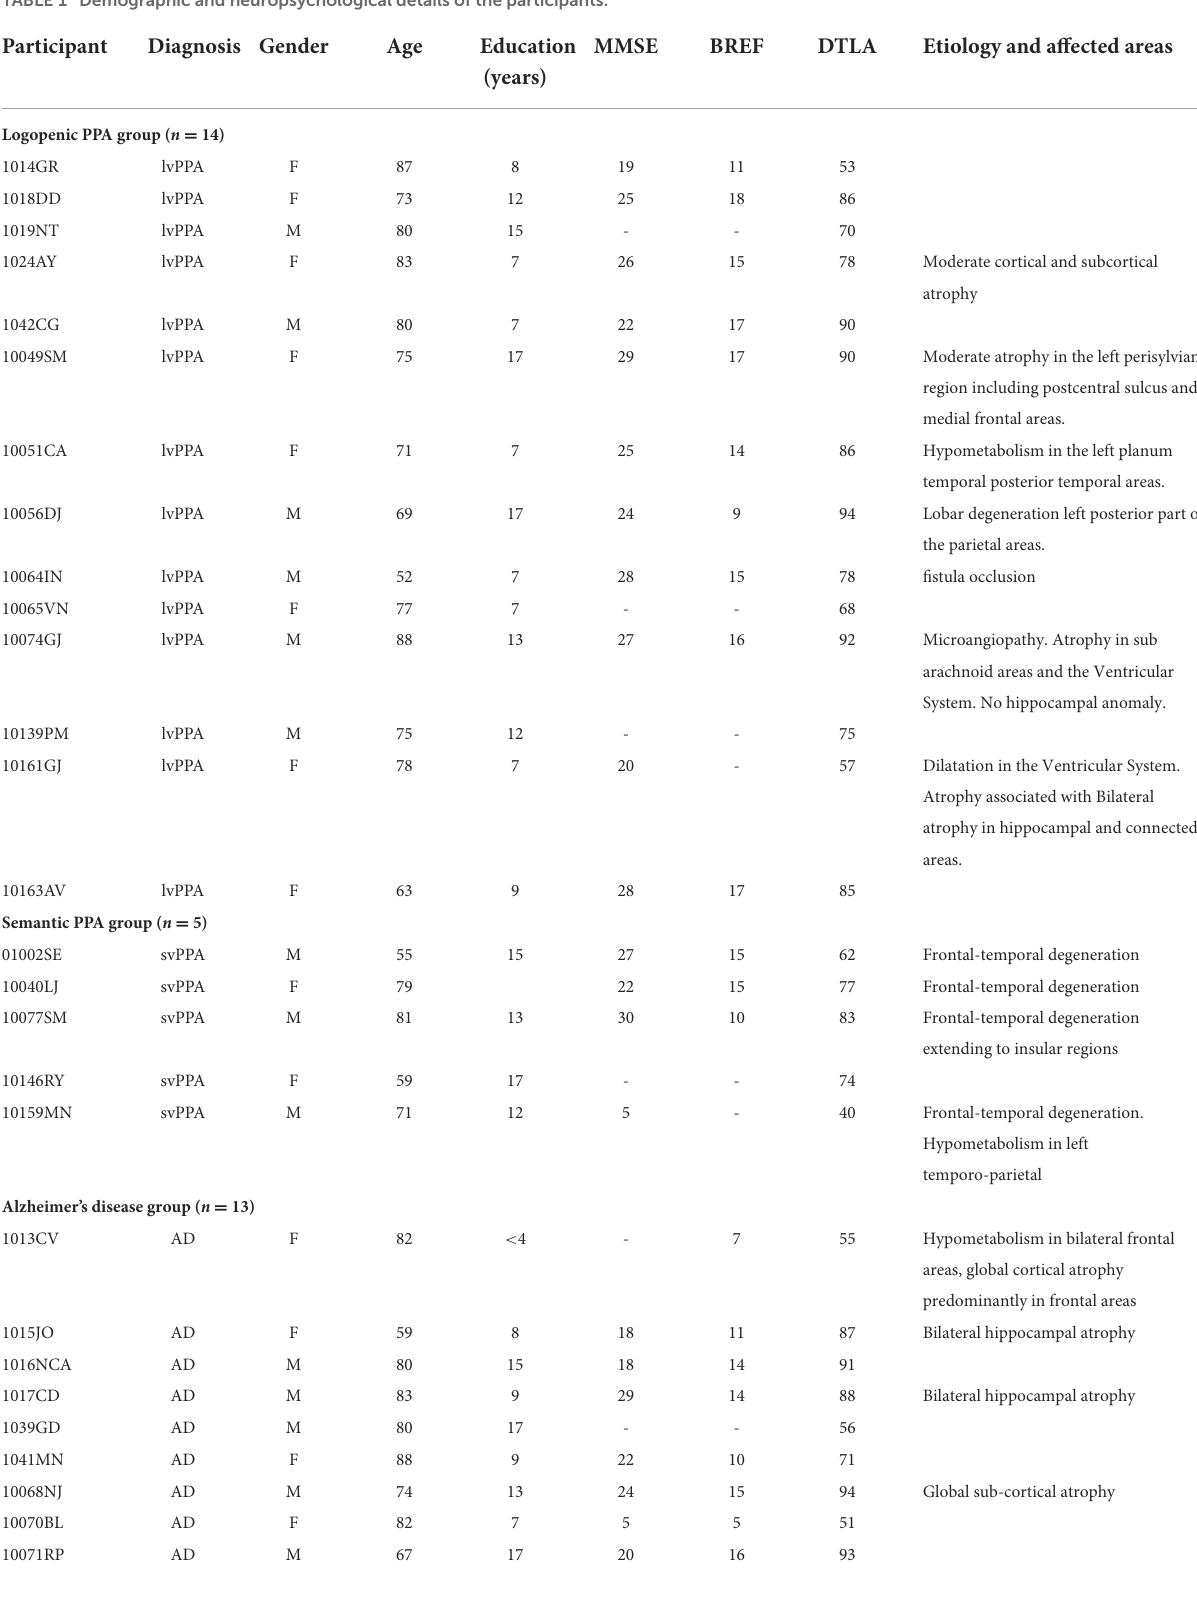
TABLE 1 Demographic and neuropsychological details of the participants. Participant Diagnosis Gender Age Education